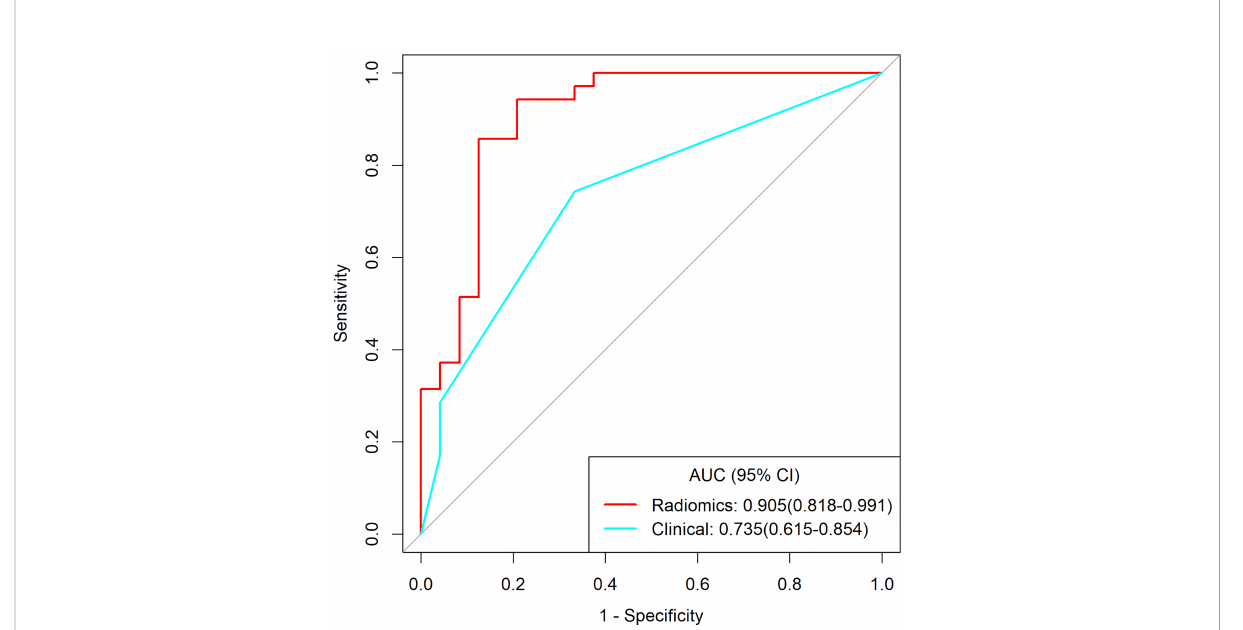
FIGURE 5 The receiver operating characteristic curves of clinical model and radiomics for distinguishing early-stage type I and type II EOC.